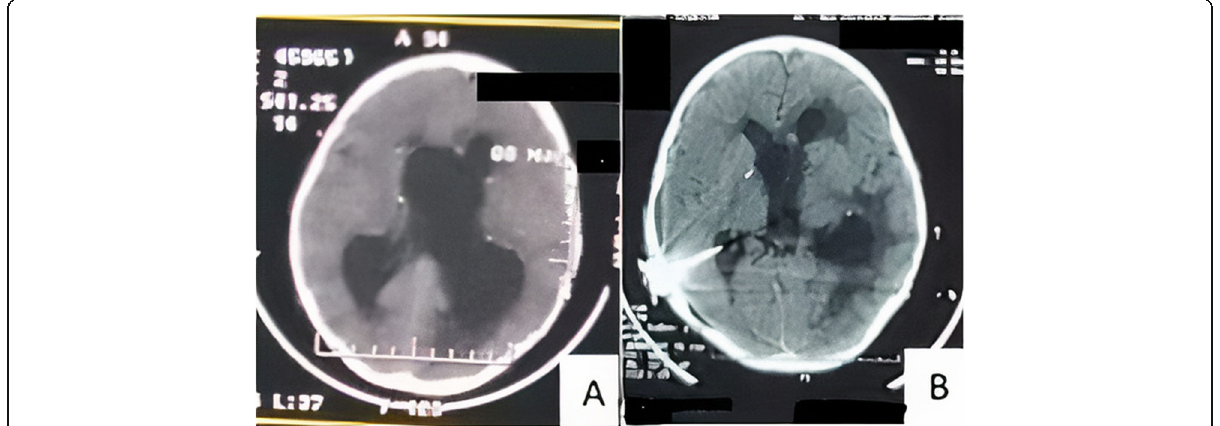
Fig. 3 a CT brain 2 days after thicoperitoneal shunt. b CT brain after high-pressure